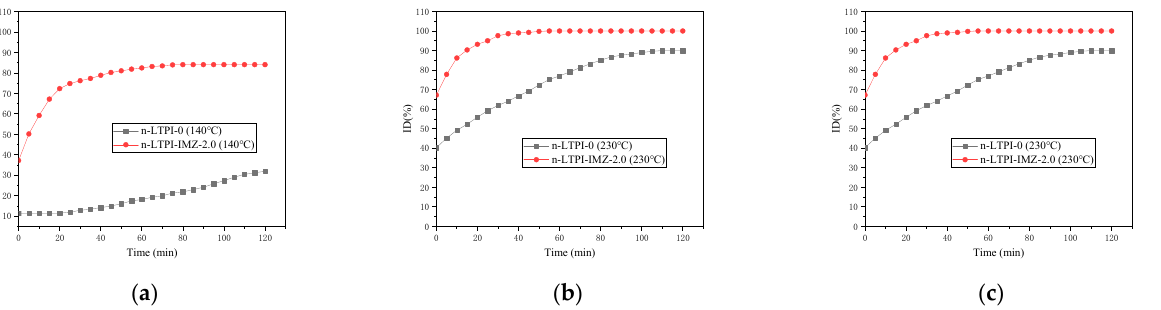
Figure 5. Effect of curing time on imidization degree (ID) of the polymer films with 2.0% of IMZ at different curing temperatures: ( a ) 140/2 h, ( b ) 230/2 h, ( c ) 350/2 h.